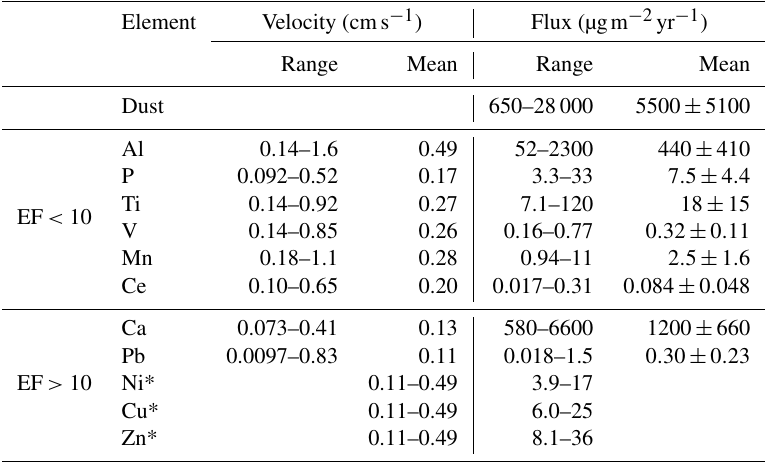
Table 3. Estimates of dry deposition velocities and dry deposition fluxes of trace elements in aerosols over Palmer Station, western Antarctic